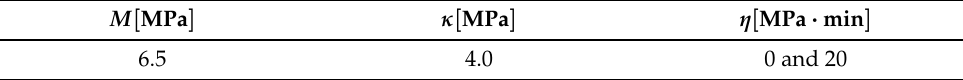
Table 2. Parameters assumed for numerical tests of the schemes including the Kepes element.